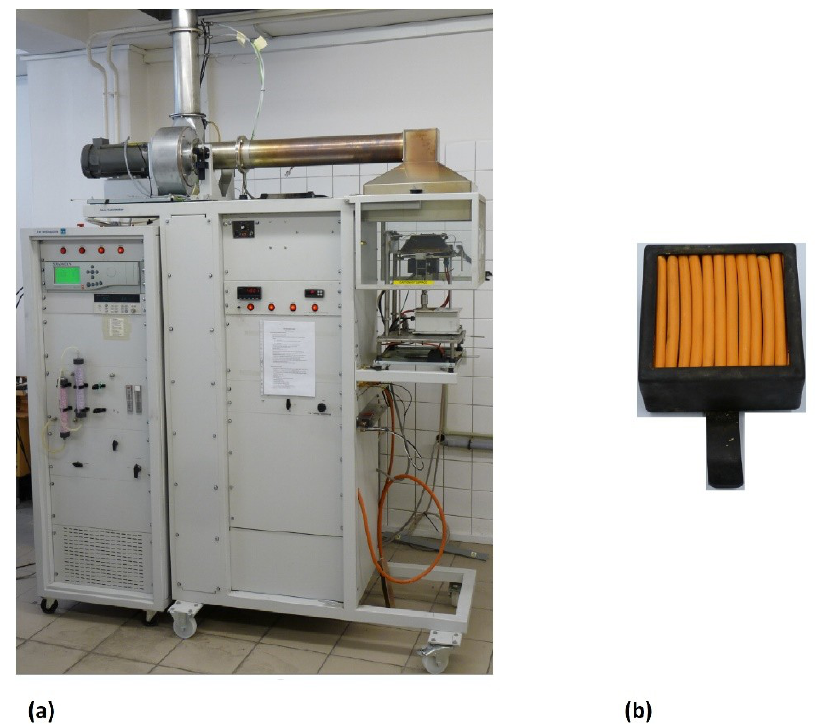
Figure 3. Photograph of cone calorimeter and samples in holder: ( a ) Cone calorimeter, ( b ) Samples in holder.